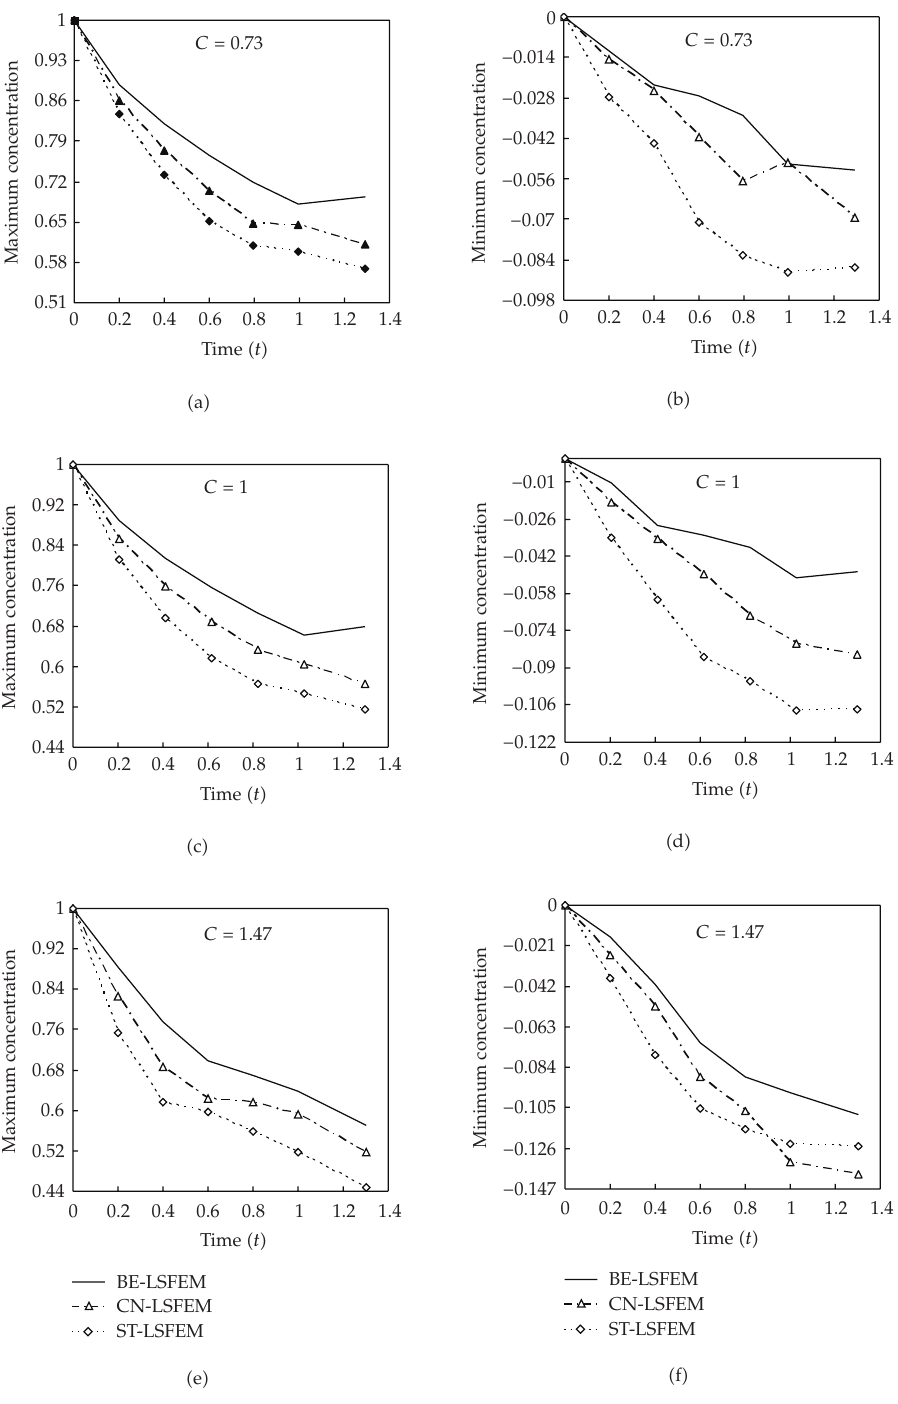
Figure 4: Variation of maximum and minimum concentrations with time for advection of concentration spike : comparison of results over the time of